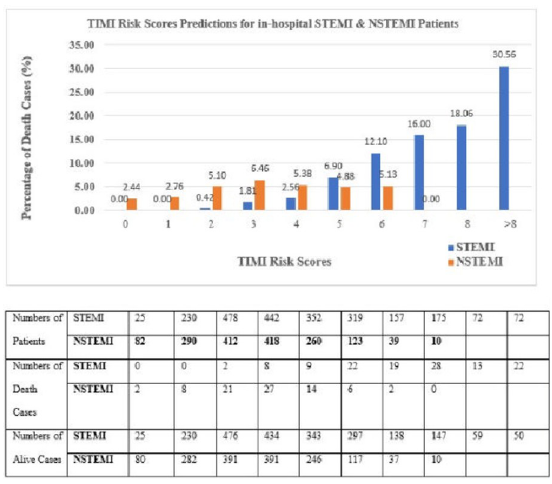
Fig 6. Breakdown of performance by the TIMI model for in-hospital mortality prediction for both STEMI and NSTEMI patients.